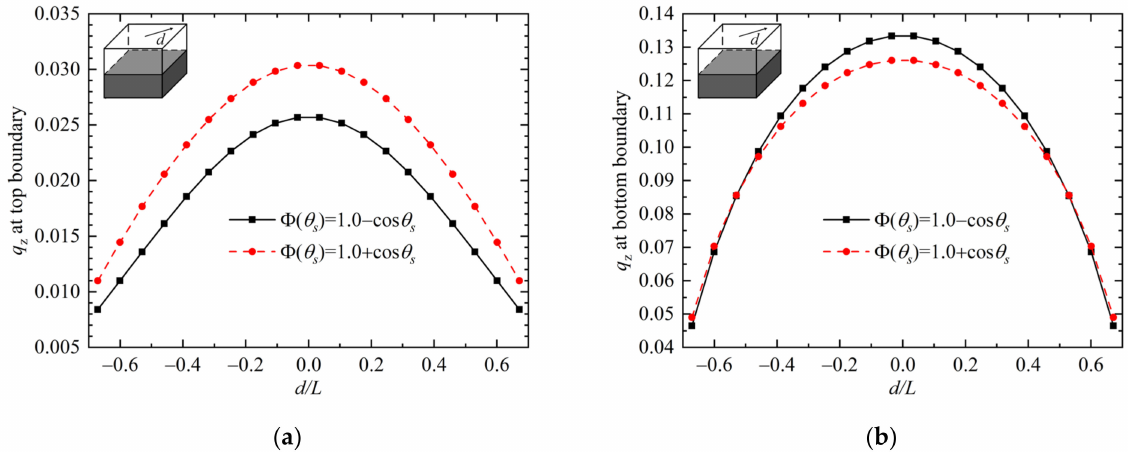
Figure 9. Heat flux with different scattering phase functions in Case 2: ( a ) results at top boundary; ( b ) results at bottom